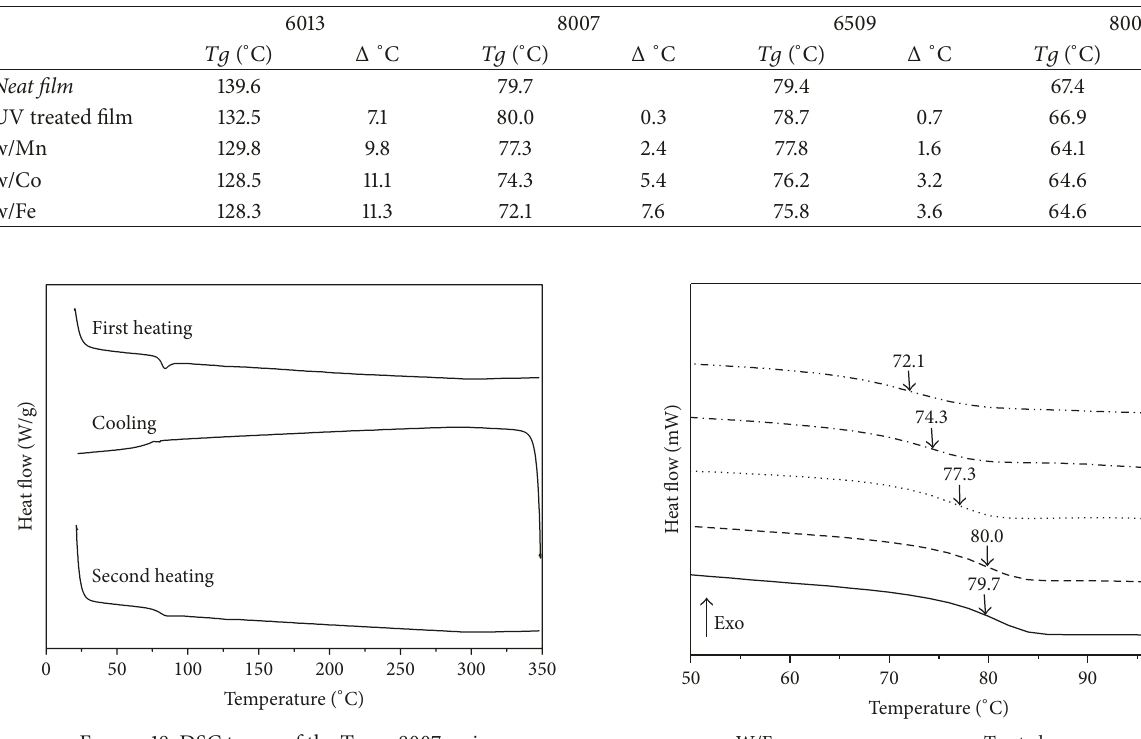
Figure 18: DSC traces of the Topas 8007 resin.